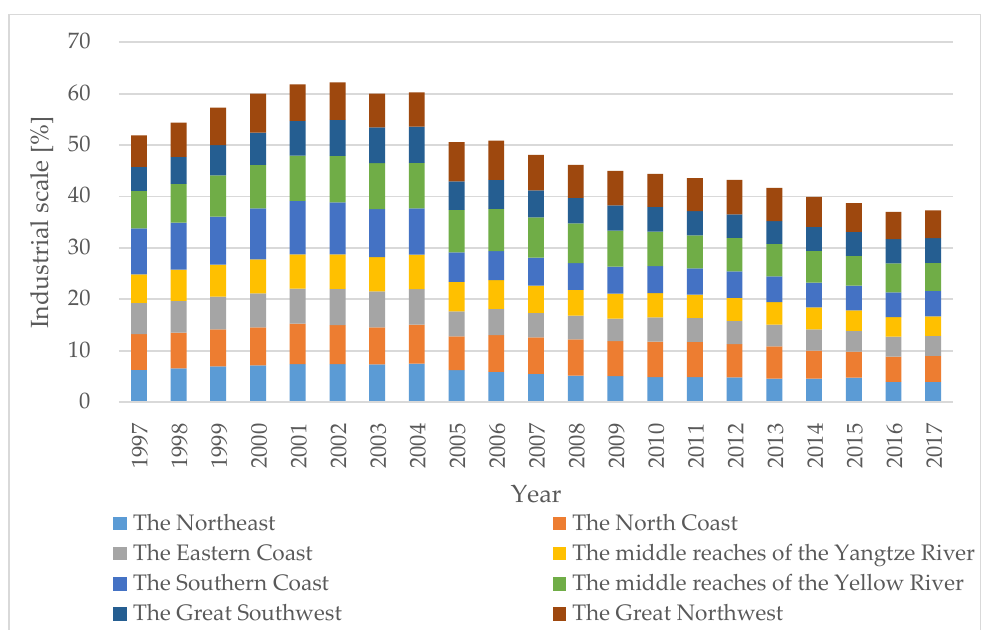
Figure 4. Regional energy intensities in China from 1997 to 2017.